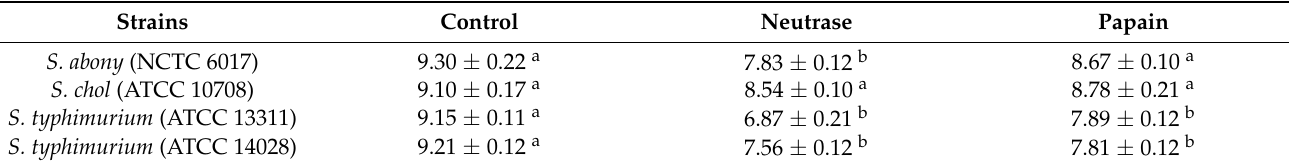
Table 2. Cell viable counts (log CFU/mL) of Salmonella strains in the presence of collagen acetone peptide fractions derived from two enzymatic